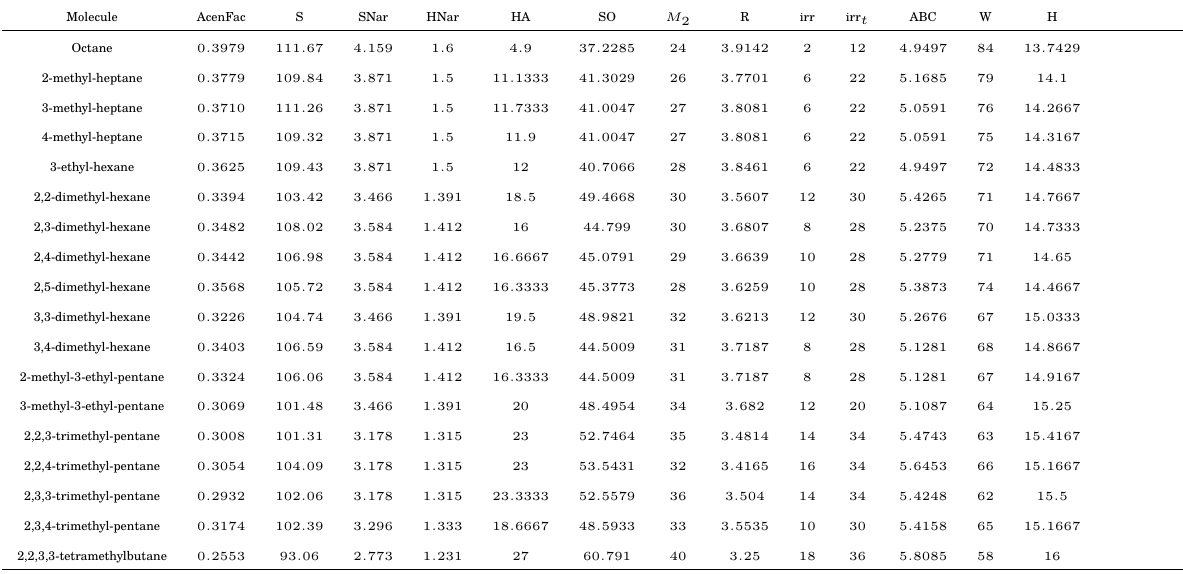
Table 1: Experimental values of acentric factor (AcenFac), entropy (S), SNar, HNar and the corresponding values of different topological indices for octane isomers.